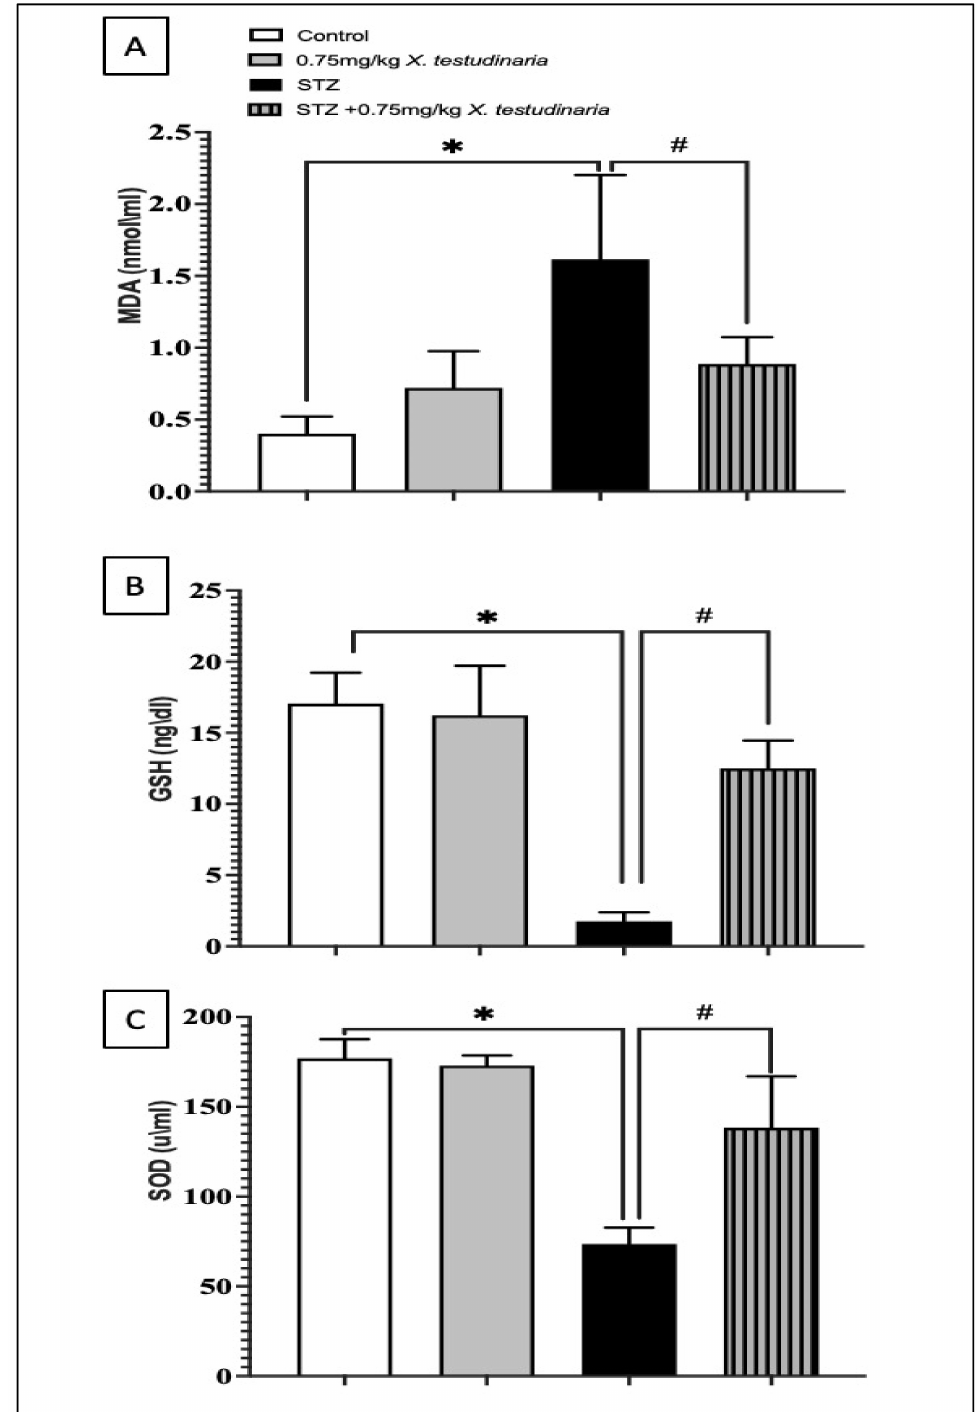
Figure 7. Effect of X. testudinaria extract on oxidative biomarkers in the dorsal root ganglia (DRG) of streptozotocin (STZ)-induced diabetic neuropathic mice: ( A ) malondialdehyde (MDA) level, ( B ) glutathione (GSH) level, and ( C ) superoxide dismutase enzymes (SOD) level. Data are presented as mean ± SD for mice (n = 6) in each group. Statistical analysis was carried out using a one-way ANOVA followed by Tukey post hoc test. *: statistical significance from the corresponding control group was set at p < 0.05. #: statistical significance from the corresponding STZ group was set at p <